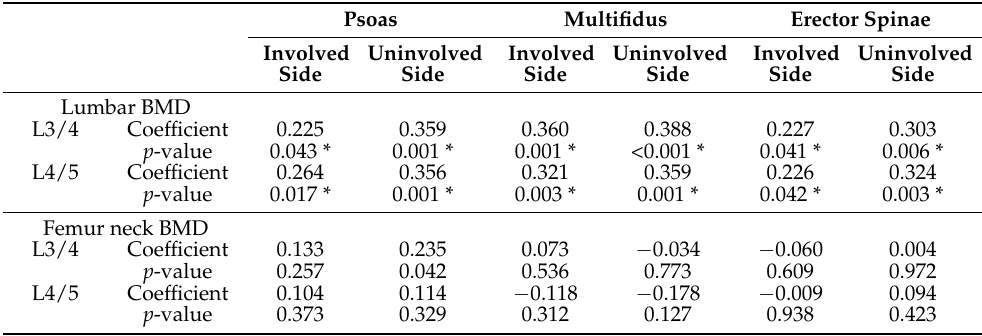
Table 4. Pearson correlation analysis to analyze the correlation between the functional ratio of the lumbar spinal muscles and lumbar